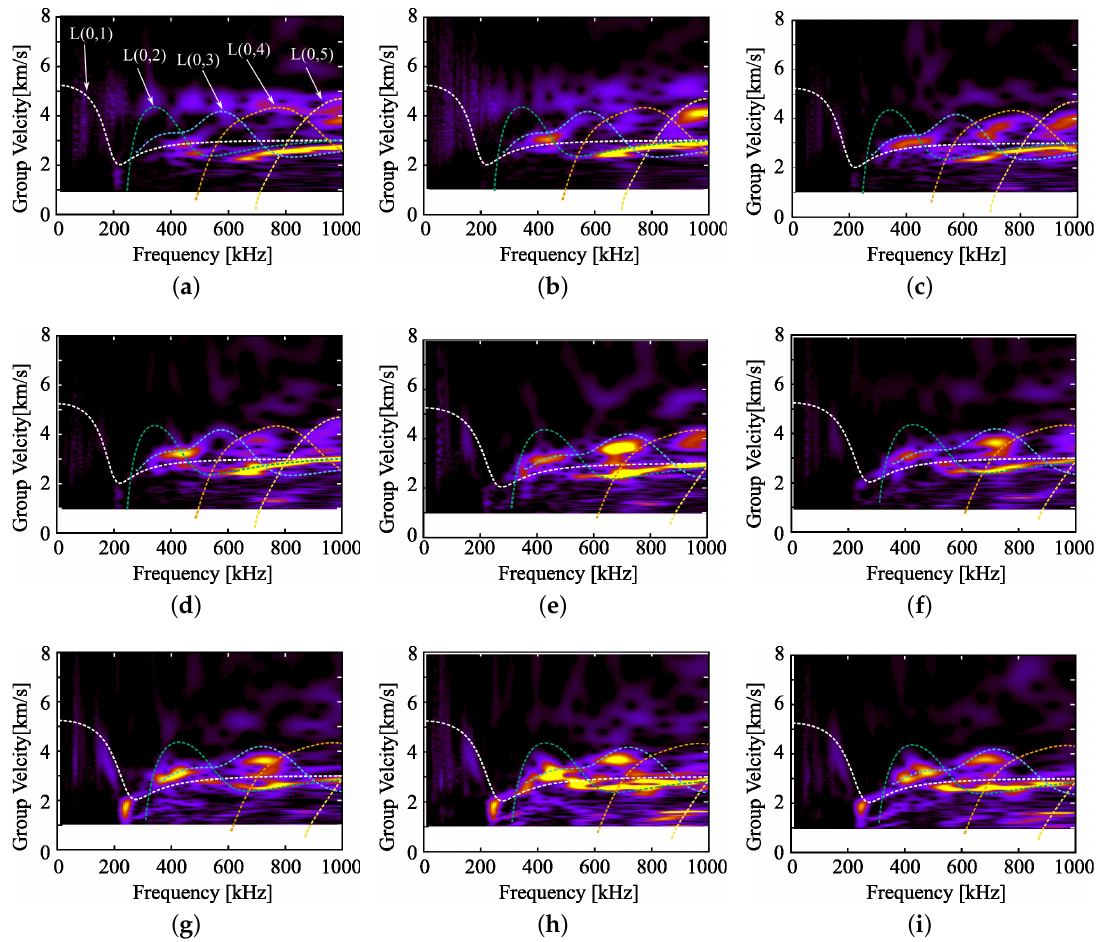
Figure 9. Comparison between the wavelet transform of each ultrasonic signal in Figure 8a and group velocity dispersion curves; ( a – i ) correspond to the results of 0, 8, 16, 24, 32, 40, 48, 56, and 60 h, respectively. The rod diameter a for calculating Equation 3 was 0.75 mm for ( a – d ) and 0.60 mm for ( e – i ).